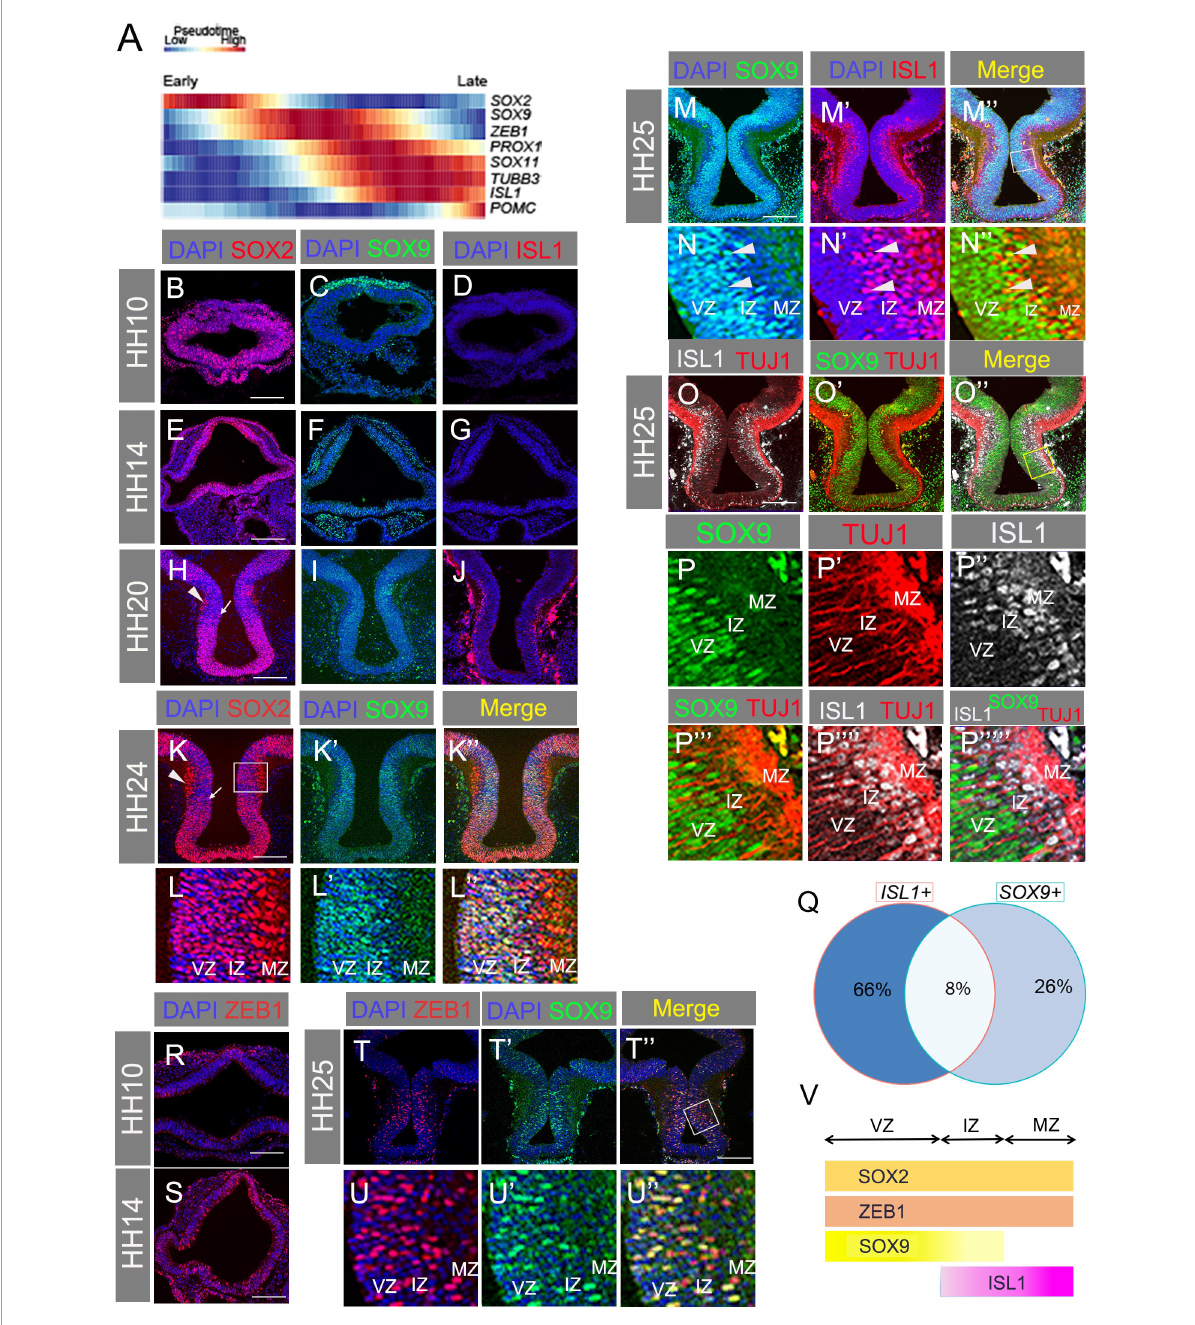
FIGURE2 (A) Pseudotime trajectory of maturing chicken tuberal hypothalamic cells from HH8 to HH21, showing relative expression levels of the factors indicated. (B–J) Transverse sections through basal hypothalamus at HH10, 14, and 20 with antibody labelling for SOX2 (B,E,H) , SOX9 (C,F,I) , and ISL1 (D,G,J) . (K–L”) Transverse section through HH24 hypothalamus co-labelled with SOX2 and SOX9 antibodies. Box in panel (K) indicates region shown in panels (L–L”) . Note that SOX2 expression is reduced in the VZ/IZ, and highest in the MZ in the boxed area in panel (K) , which is shown in panels (L–L”) . Arrowhead = high MZ expression of SOX2; Arrow = lower VZ/IZ expression of SOX2. (M–N”) Transverse section through HH25 hypothalamus co-labelled with antibodies for SOX9 and ISL1. (M”) Merged image with box indicating area expanded in panels (N–N”) . Arrowheads indicate co-expressing cells. (O–P””’) Transverse section through HH25 hypothalamus co-labelled with antibodies for TUJ1, SOX9, and ISL1. (O”) Merged image with box indicating area expanded in panels (P–P””’) . (Q) Venn diagram showing percentage of ISL1 - and SOX9 -expressing cells that are single and double positive for these markers. (R,S) Transverse section through hypothalamus at HH10 (R) and HH14 (S) with antibody labelling of ZEB1. (T–U”) Transverse section through HH25 hypothalamus co-labelled with antibodies for ZEB1 and SOX9. (T”) Merged image with box indicating area expanded in panels (U–U”) . (V) Schematic summarising the zonal locations of SOX2, ZEB1, SOX9, and ISL1. VZ, ventricular zone; IZ, intermediate zone; MZ, mantle zone. Scale bars: all 160 µ